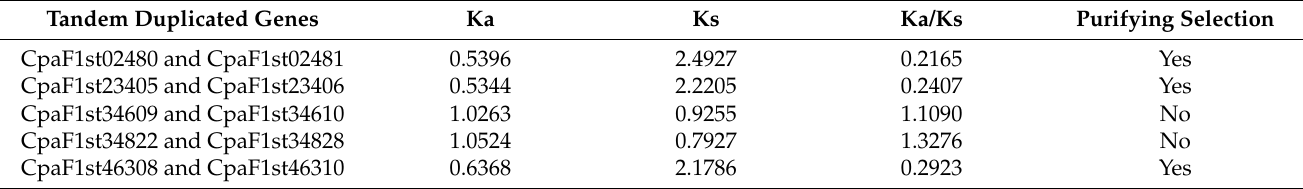
Table 2. Analysis of tandem duplication events of MADS-box gene pairs in C. paliurus . Tandem Duplicated Genes Ka Ks Ka/Ks Purifying Selection CpaF1st02480 and CpaF1st02481 0.5396 2.4927